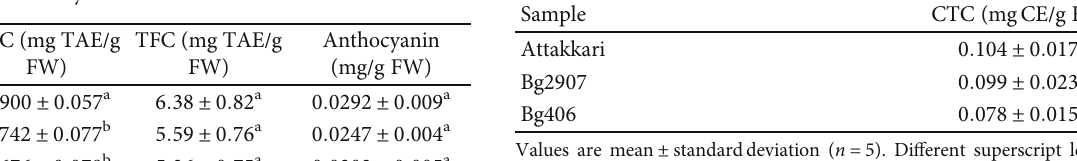
Table 2: The total phenolic content, the total fl avonoid content, and the monomeric anthocyanin content.